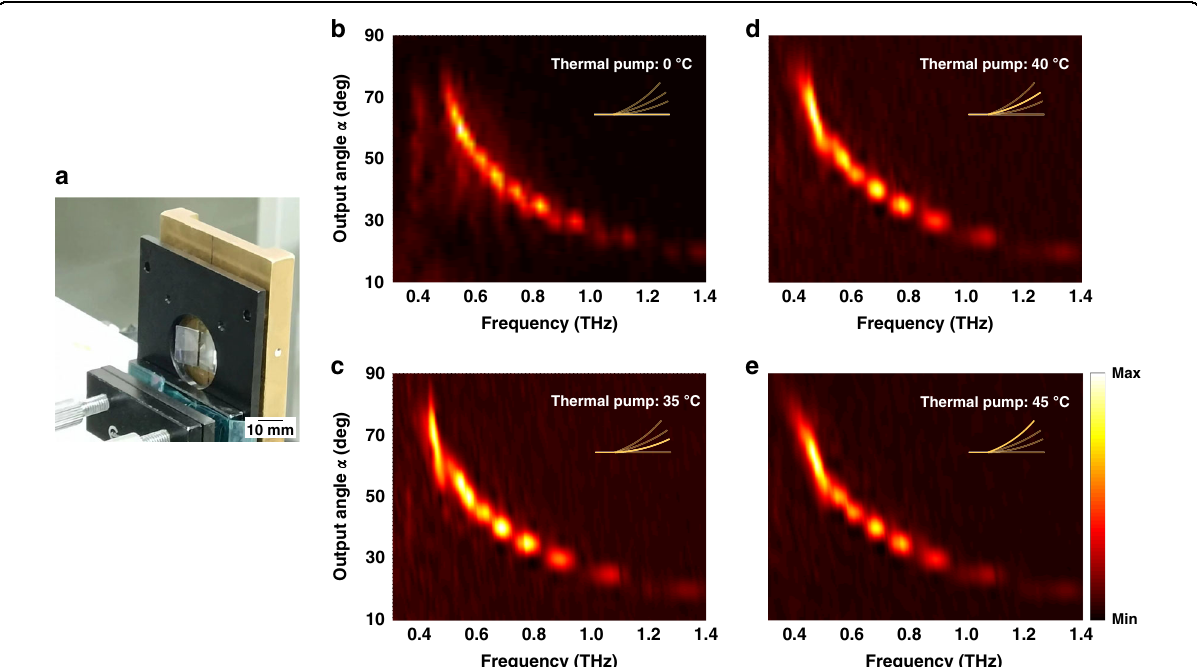
Fig. 5 Thermal regulation of the LCE metasurface. a The photo of the mounted LCE de fl ector and hot plate. b – e Frequency-resolved output angles of the LCE metasurface under 22 °C room temperature, 35, 40, and 45 °C. The insets illustrate the curling of the LCE